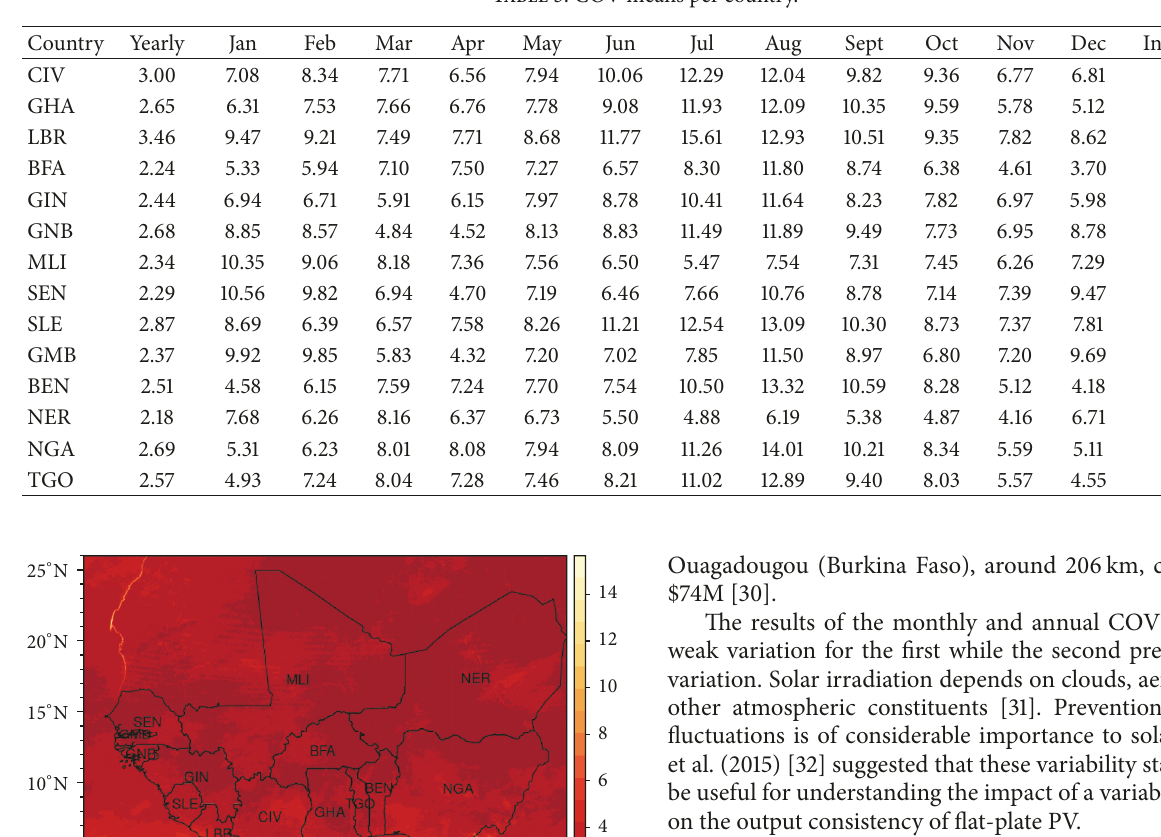
Table 5: COV means per country.